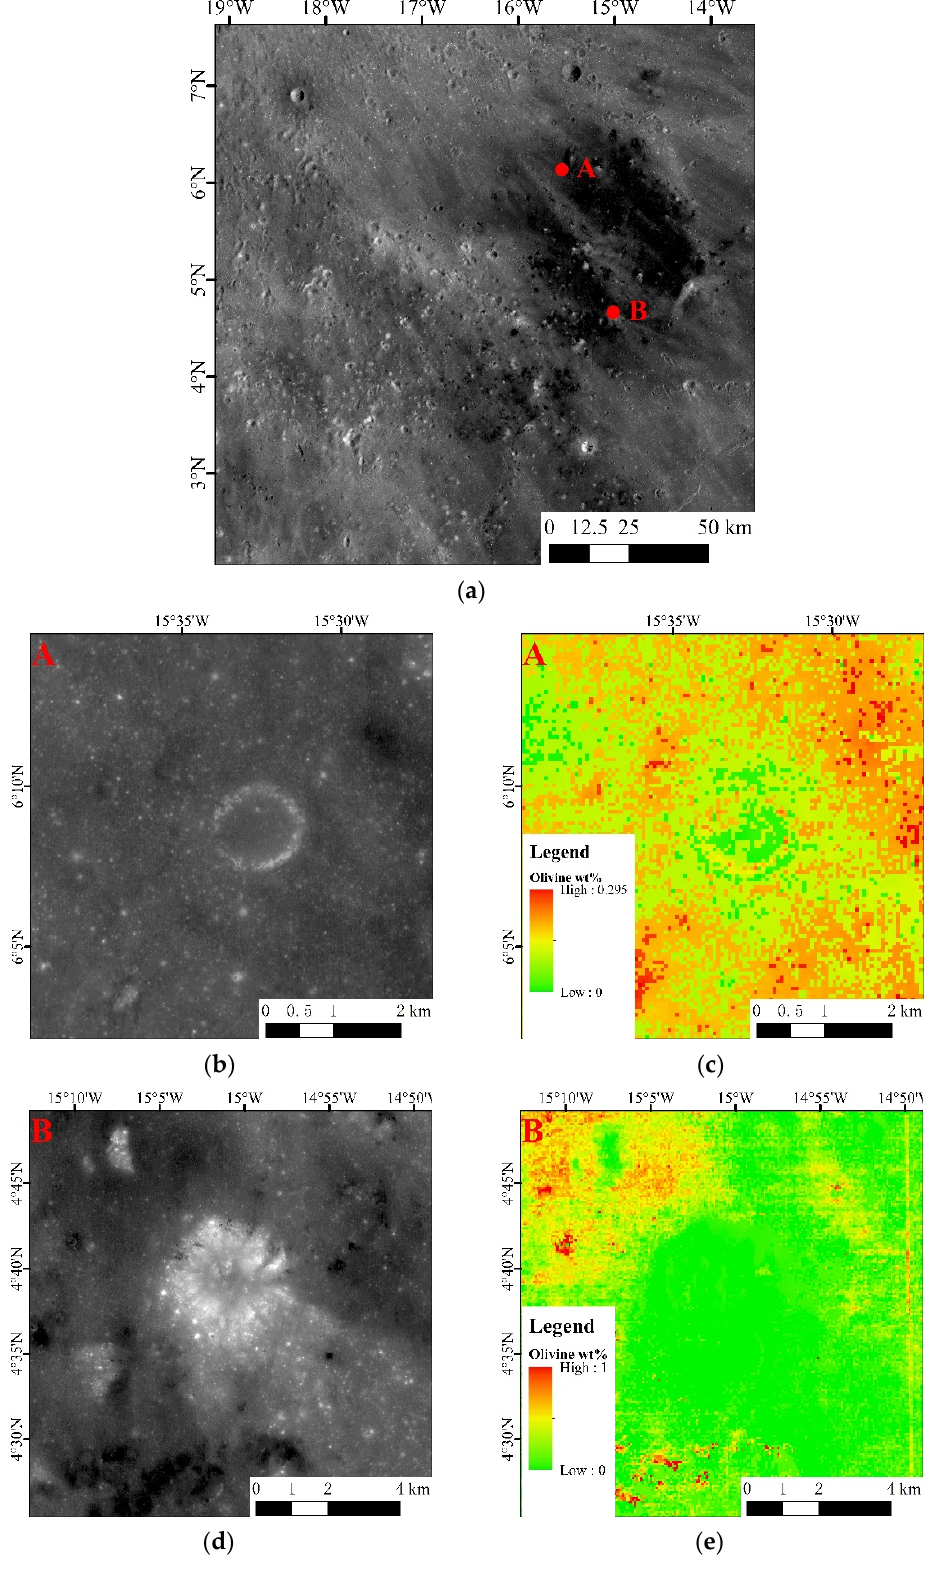
Figure 16. Two craters in the Sinus Aestuum- Ⅰ DMD. ( a ) Position of the craters on the Sinus Aes- tuum- Ⅰ DMD shown on the Kaguya TCortho Mosaic; ( b ) Crater A shown on the CE2 DOM G222; ( c ) Olivine map of Crater A; ( d ) Crater B shown on the CE2 DOM G222 and G223; ( e ) Olivine map of Crater B.